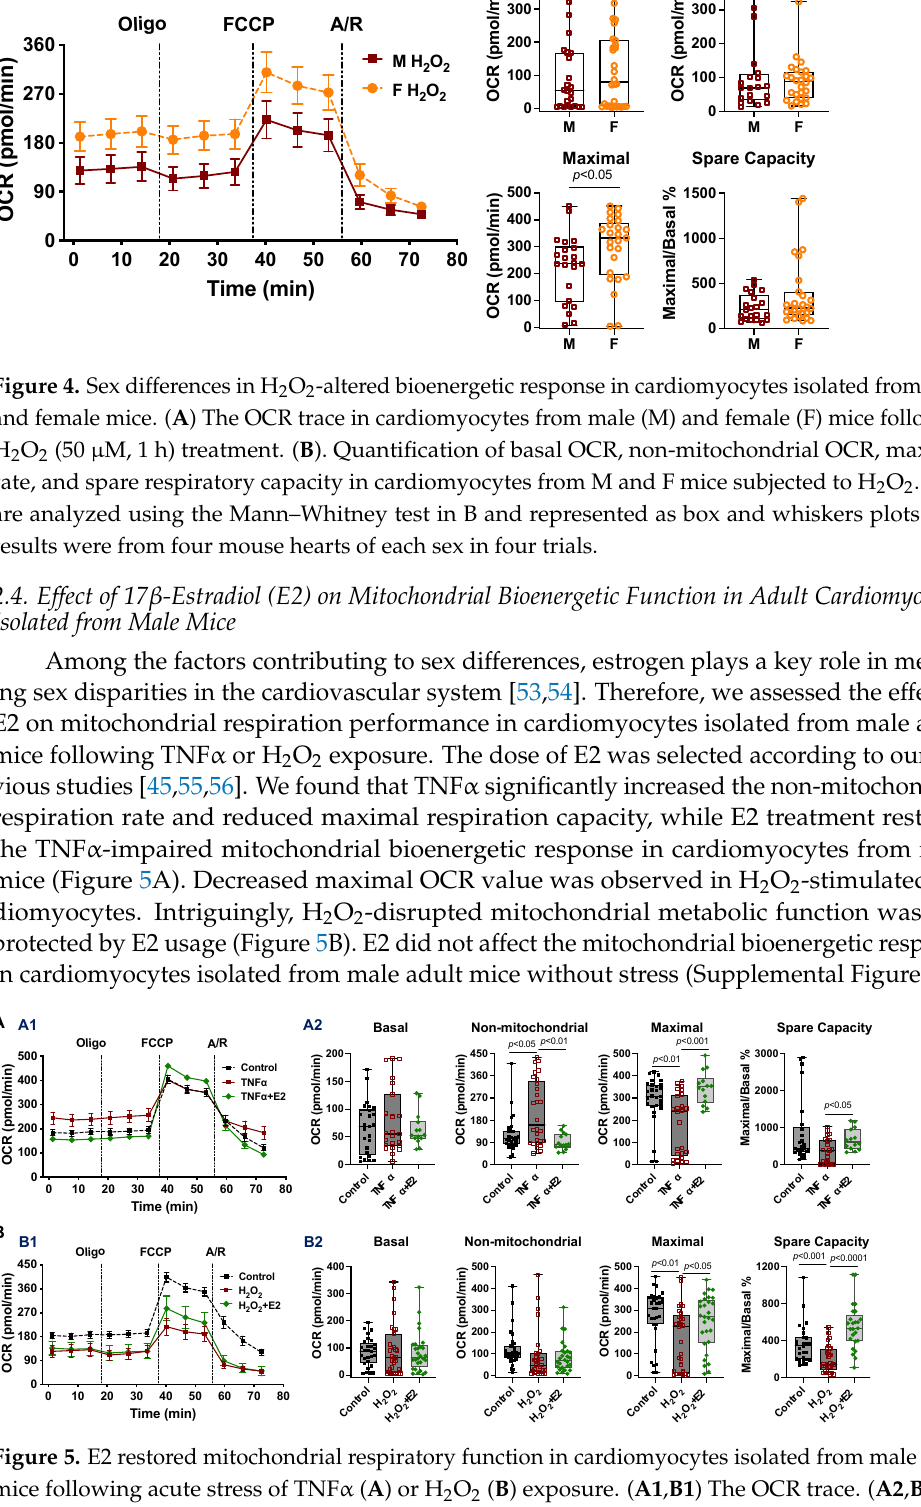
Figure 5. E2 restored mitochondrial respiratory function in cardiomyocytes isolated from male adult mice following acute stress of TNF ⍺ ( A ) or H2O2 ( B ) exposure. ( A1 , B1 ) The OCR trace. ( A2 , B2 ) E2 (100 nM) treatment restored TNF ⍺ - or H2O2-impaired mitochondrial respiration function (maximal OCR and spare respiratory capacity) in cardiomyocytes. Data were evaluated using the Kruskal– Wallis test in ( A2 , B2 ) and are shown as box and whiskers plots. The results were from at least three male mouse hearts in at least three